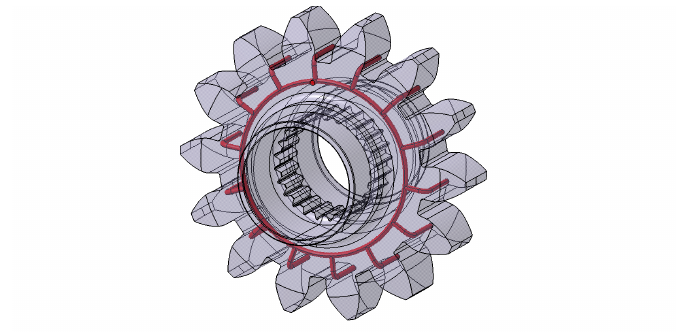
Figure 1. Embedded capillaries (in red) of the effective Structural Health Monitoring System (eSHM)